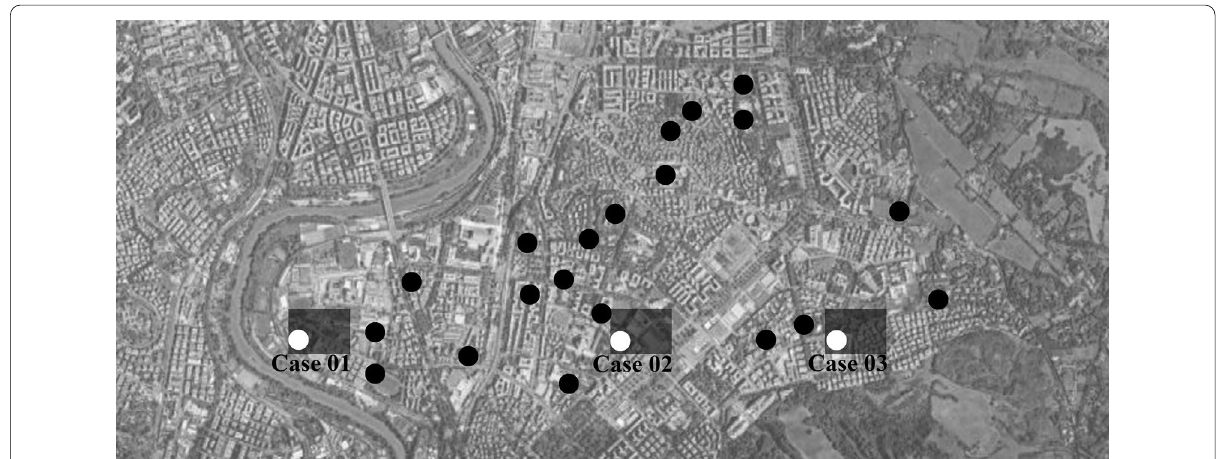
Fig. 2 Distribution of school buildings within the District: selection of the case studies